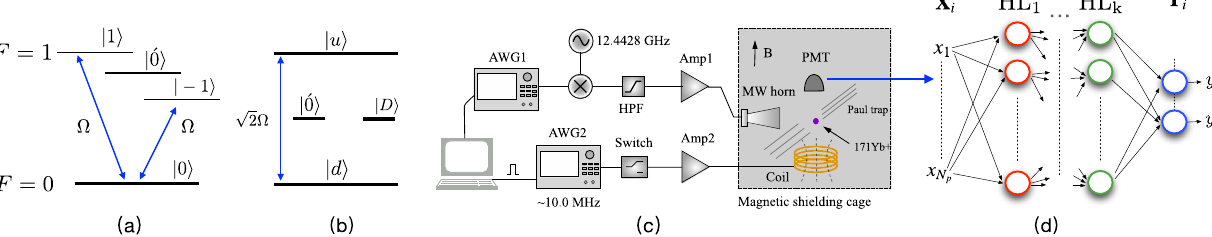
Fig. 1 Schematic levels of the 171 Yb + atomic sensor and the experimental setup. a Relevant levels of the 171 Yb + atomic sensor. Two resonant MW fi elds drive the sensor with a Rabi frequency Ω leading to the con fi guration in ( b ) which is de fi ned in the dressed state basis (cid:1) (cid:3) (cid:1) ; D j ig 9 . c Schematic con fi guration of the experimental setup. The ion is trapped in a needle trap which consists of a pair of RF f u j i ; d j i ; (cid:1) 0 electrodes and four DC electrodes. The MW fi elds for state manipulation are generated by mixing a 12.4428 GHz signal with the signal from an arbitrary waveform generator (AWG1). The 12.6 GHz signal after a high pass fi lter (HPF) is ampli fi ed by an ampli fi er (Amp1) and sent to the ion using a MW horn outside the vacuum chamber. The target fi eld around 10 MHz is generated by another arbitrary waveform generator (AWG2) controlled by the computer and broadcast to the ion through a coil after ampli fi cation. We place an extra RF switch after AWG2, which can be used to remove the target fi eld from the trap while keeping the signal from AWG2 continuous. A photomultiplier tube (PMT) is used to detect the state-dependent fl uorescence. d Scheme of the NN. The response from PMT, i.e., X , is processed by a number of hidden layers (HL 1 ... HL k ) leading to the outputs Y . Table 1. Outputs y 1 obtained from the NN in Scenario